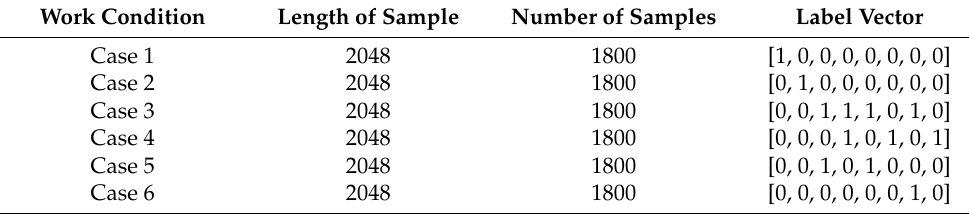
Table 9. Sample and Label Instructions.